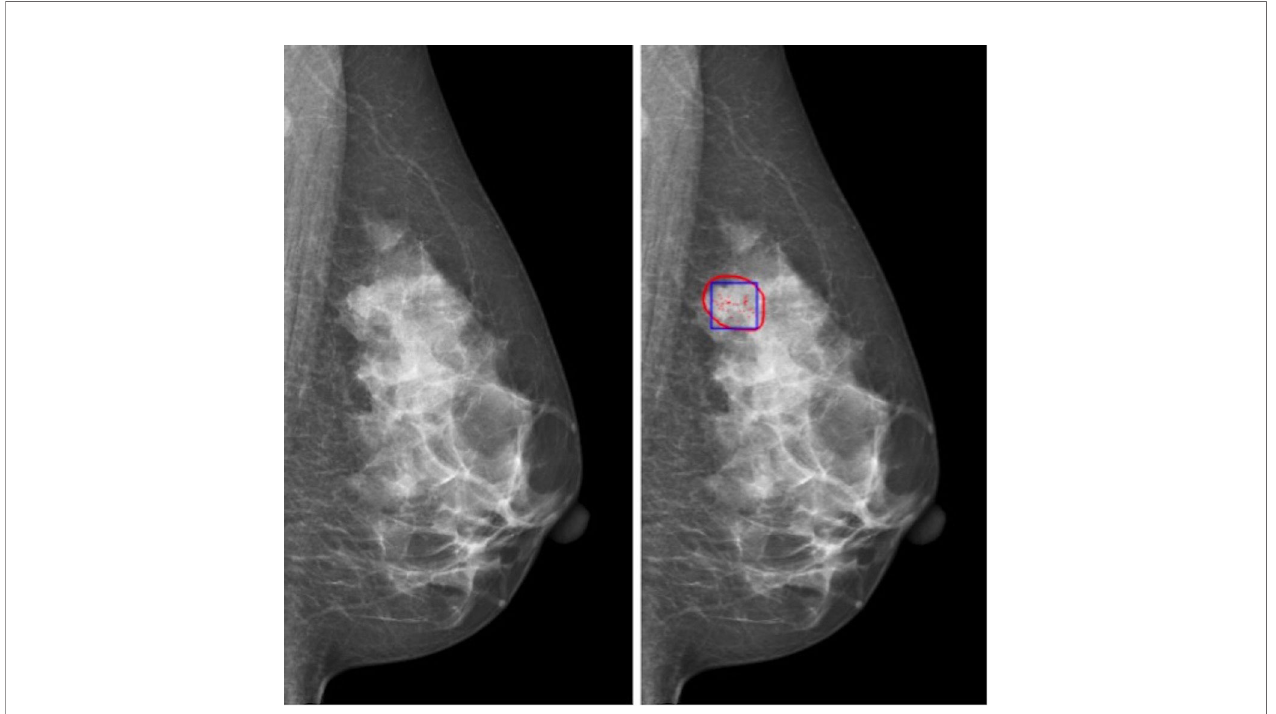
FIGURE 1 | Region of interest of microcalci fi cation cluster for classi fi cation: (left) original image; (right) red contour is the possible region of interest of microcalci fi cation, and blue box is the region of interest of microcalci fi cation cluster for classi fi cation.